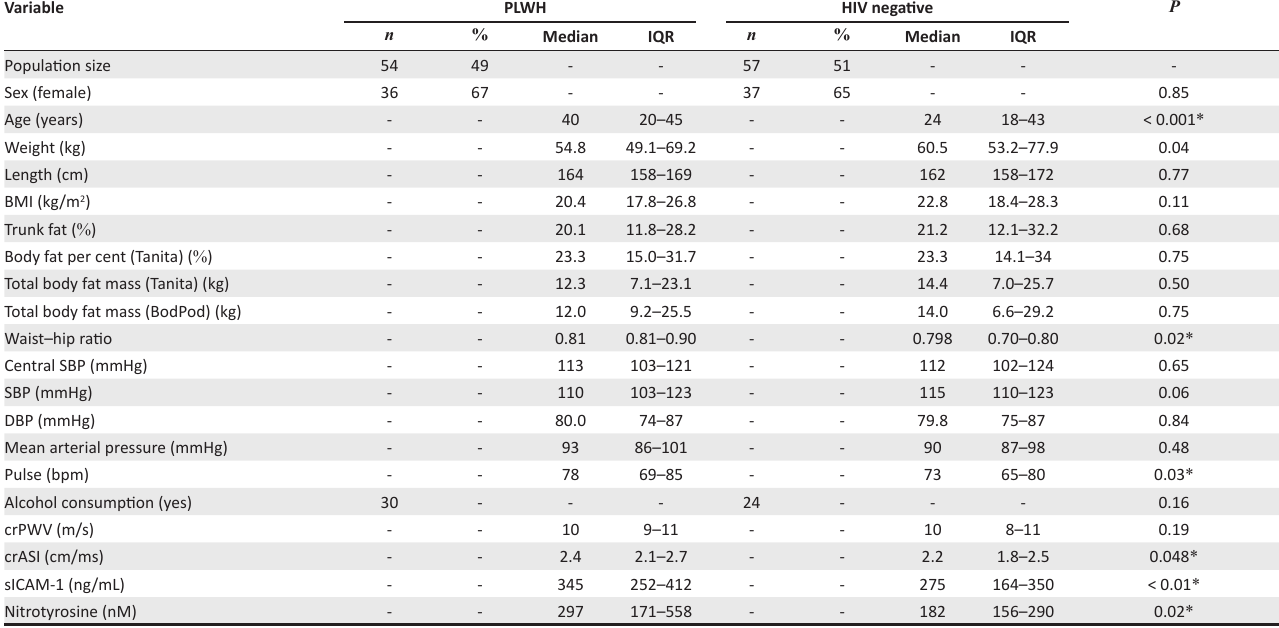
TABLE 1: Clinical characteristics comparing persons living with HIV and the control (HIV-negative persons). Variable